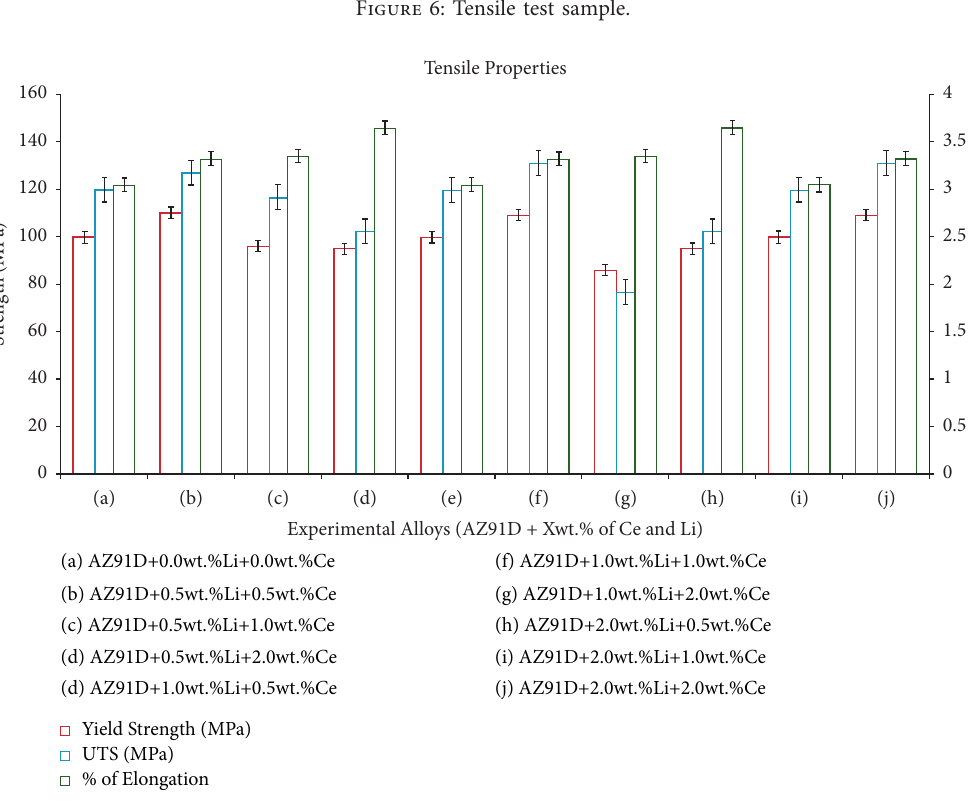
Figure 7: Graphical Histogram of Tensile test